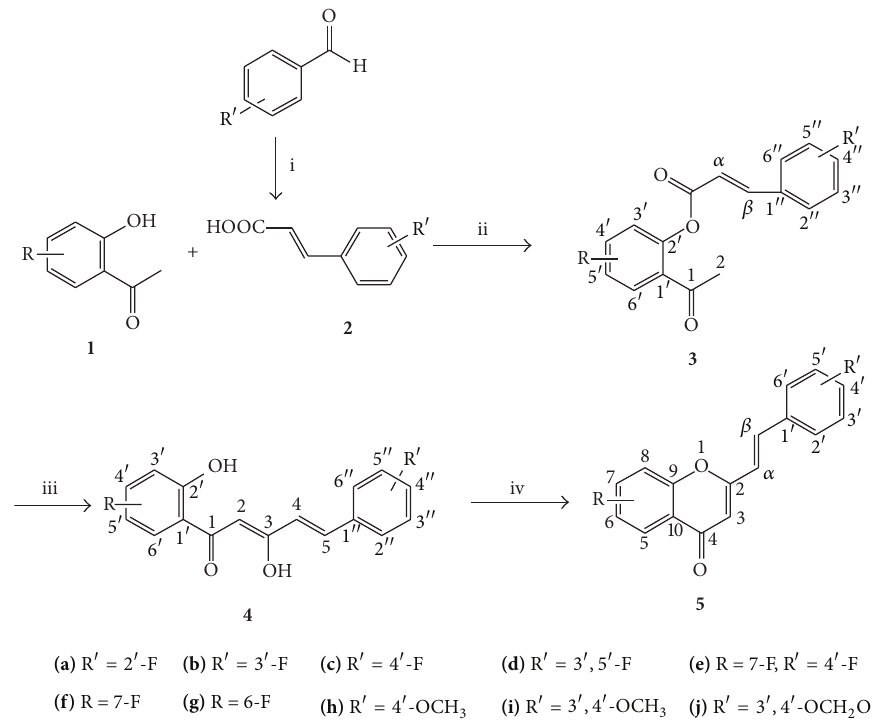
Figure 1: The preparation of 2-styrylchromones 5a–j from their corresponding acetophenones and benzaldehydes (i) malonic acid, piperidine, pyridine, 80–90 ∘ C, 4-5h, (ii) pyridine, POCl 3 , rt. 4-5 h, (iii) DMSO, KOH, rt. 2 h, and (iv) DMSO, PTSA, 90–95 ∘ C, 2-3